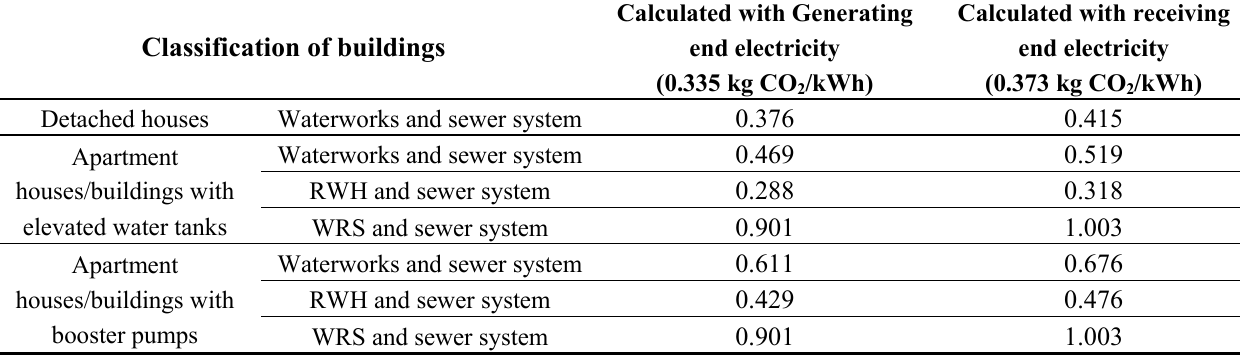
Table 5. CO emission factors of Japanese water system (kg CO 2